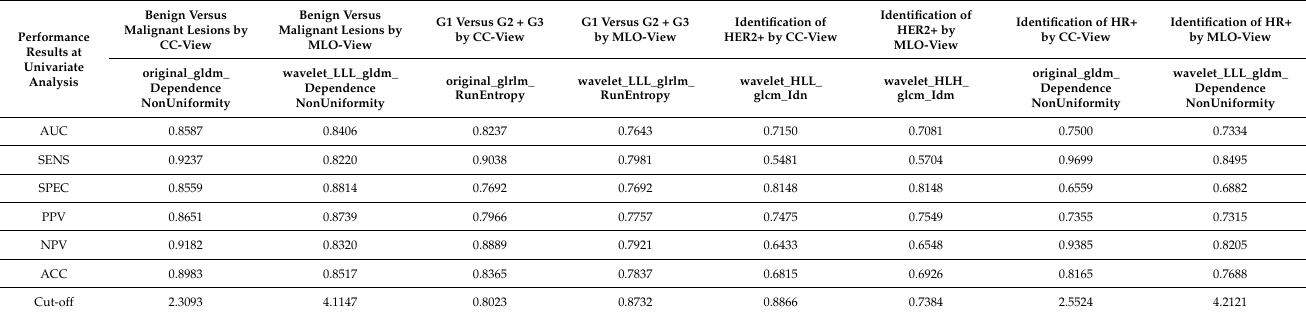
Table 2. Performance results of univariate analysis both on CC and MLO